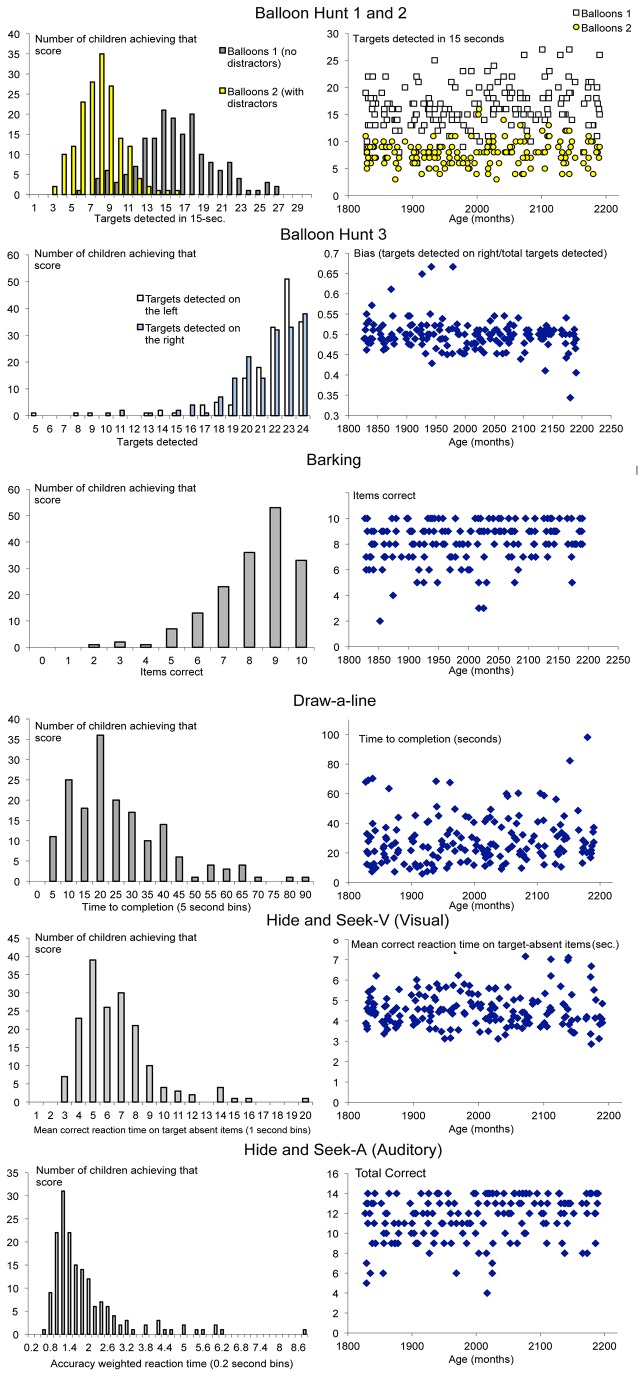
Score distributions from key TEA-ChJ variables.